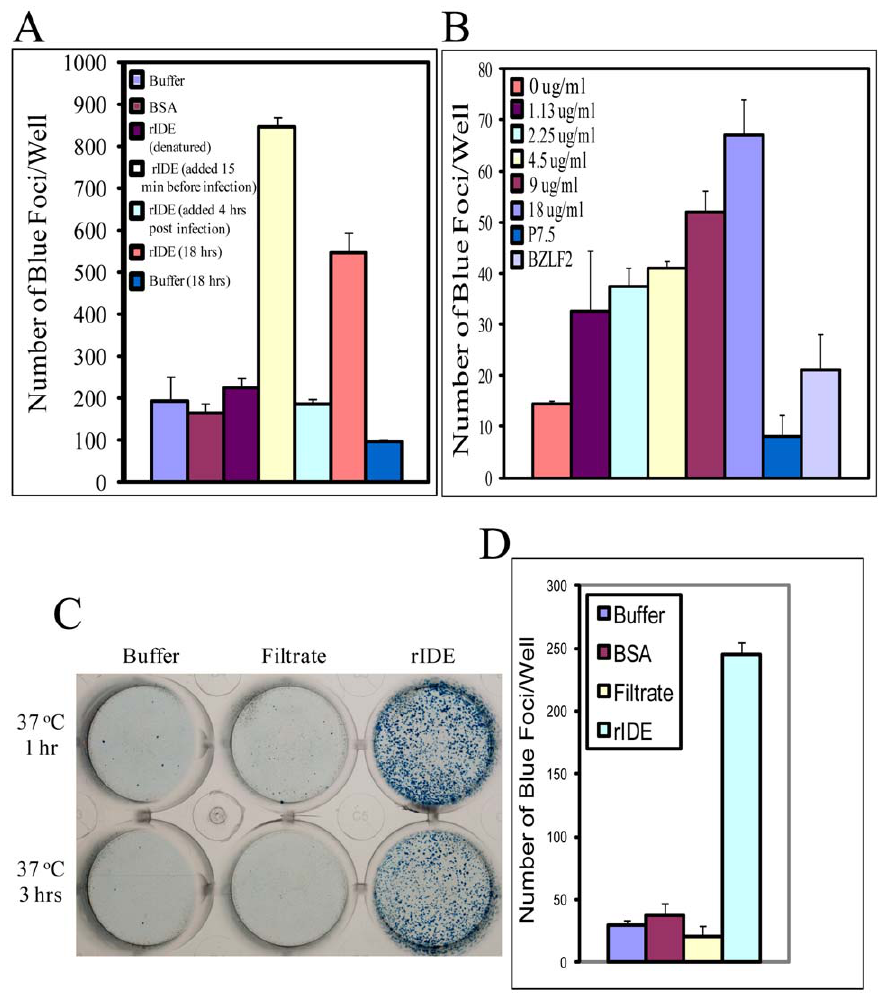
Figure 2. rIDE enhances VZV infectivity at an early stage of infection and increases the stability of virus. (A) Cell-free VZV (ROka-LacZ) virus was pre-treated with buffer, bovine serum albumin (BSA), rIDE (15 m g/ml), or denatured rIDE (IDE treated with acid and then base to a final neutral pH) at 37 u C for 15 min before infecting melanoma cells. Infected cells were stained with X-gal at 3 days after infection to identify the number of VZV-positive foci. The experiment was repeated 10 times and a representative experiment is shown. For the 5 th bar, cells were infected with the same amount of virus as in bars 1-4, and rIDE was then added to the cells 4 hours post-infection. For the last two bars, the virus was incubated with rIDE or buffer at 37 u C for 15 min and kept at 25 u C for 18 hrs before infecting MeWo cells. (B) Cell-free ROka-LacZ was pre-incubated with increasing concentrations of rIDE (shown in m g/ml) at 37 u C for 15 min and infected cells were stained with X-gal. The experiment was performed twice and one result is shown. The control proteins, P7.5 and BZLF2, were used at a concentration of 20 m g/ml. (C) Cell-free VZV (ROka-LacZ) was pre-incubated with rIDE, buffer, or filtrate passing through the rIDE purification column under the indicated conditions and infected cells were stained with X-gal at 4 days post-infection. The filtrate (control) consists of HA peptide which was used to elute rIDE from the purification column. (D) Cell-free ROka-LacZ virus was incubated with buffer, bovine serum albumen (BSA), filtrate that passed through without binding to a rIDE purification column, or rIDE for 18 hrs at 25 u C before infecting cells and staining with X-gal. The experiment was performed 3 times, and a representative result is